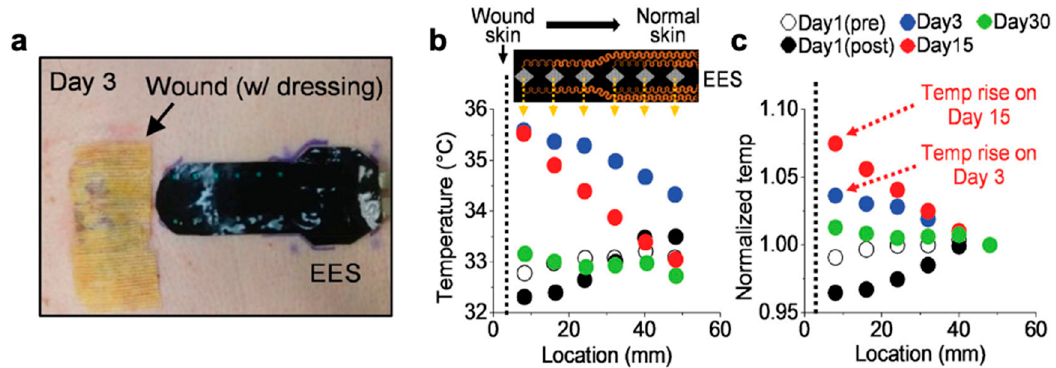
Figure 17. ( a ) A representative image of the EES mounted lateral to post-surgical suture wound on Day 3 with corresponding temperature changes measured over a month of healing ( b , c ). Reproduced with permission from [21]. Copyright John Wiley and Sons, 2014.